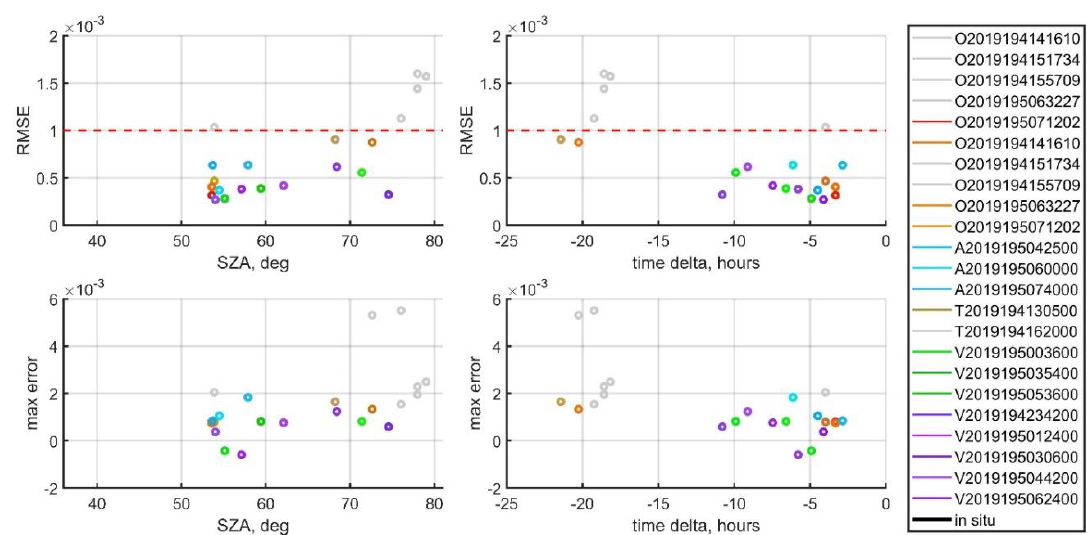
Figure 9. RMSE (top row) and maximum error (bottom row) values obtained when comparing shipboard and satellite data depending on the sun zenith angle (left column) and the time interval between data (right column). The colors of the circles correspond to the colors of the lines in Figure 1. The gray circles show the data for which the RMSE values exceed 0.001. The red dotted line on the right side of the figure corresponds to RMSE = 0.001. Station 6240, Kara Sea, 14 July 2019.